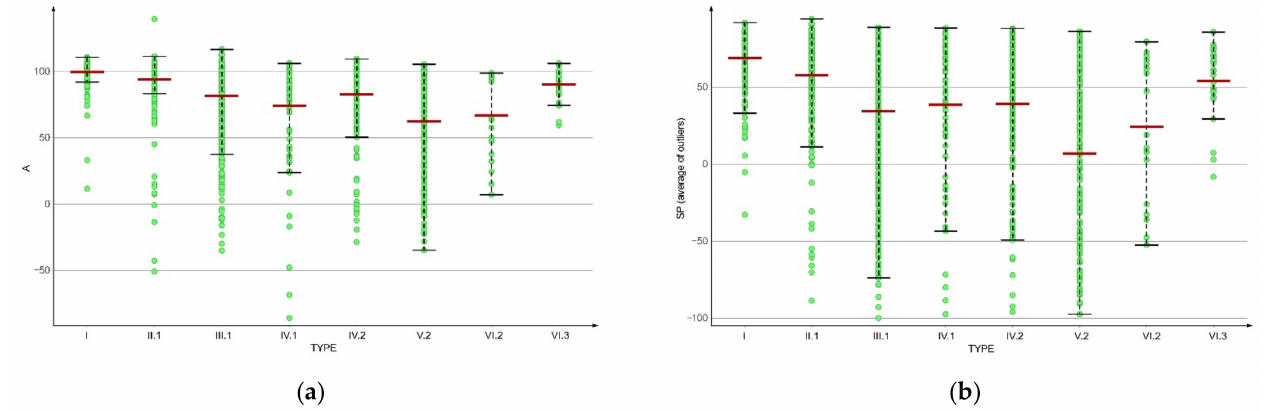
Figure 6. The evaluation of the anti-proliferative effect of the pyrazole-based derivatives depending on the BM skeleton types: ( a ) the A score; ( b ) the SP score.